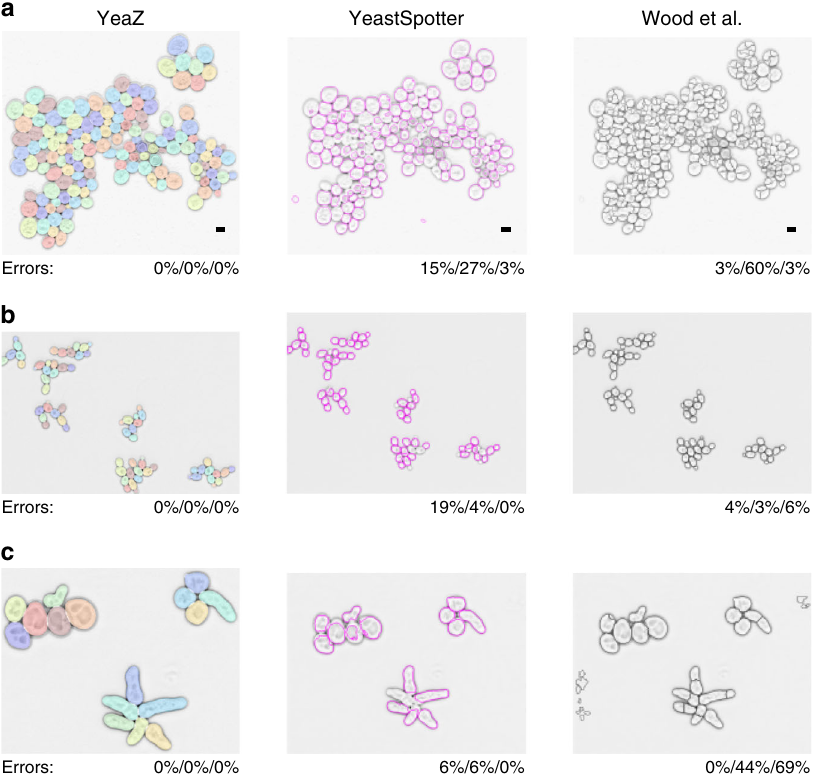
Fig. 4 Comparison of YeaZ with YeastSpotter and Wood et al. 9 . a Image recorded by us but not included in the training set. b Image from ref. 16 showing cycling cells. c Image from ref. 16 showing pheromone-arrested cells. The error values represent the fraction of missed cells/of bad contours/and of spurious cells. Phase contrast images are inverted for better visualization. Scale bar in row a : 5 μ m. Images in rows ( b , c ) from ref. 16 , scale bar